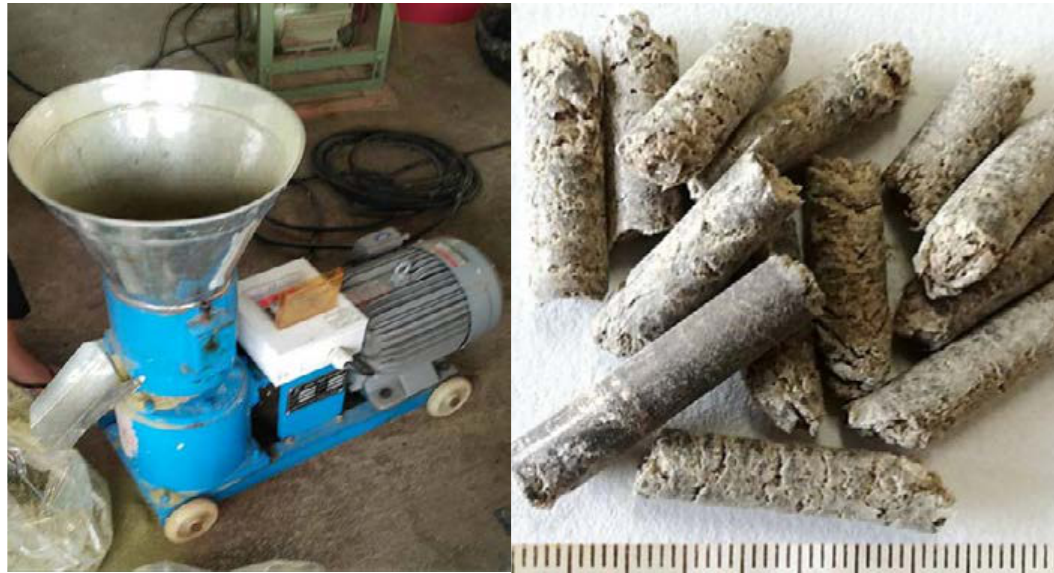
Fig. 1 : A flat-die pelletizing machine and the PET/biomass pellets